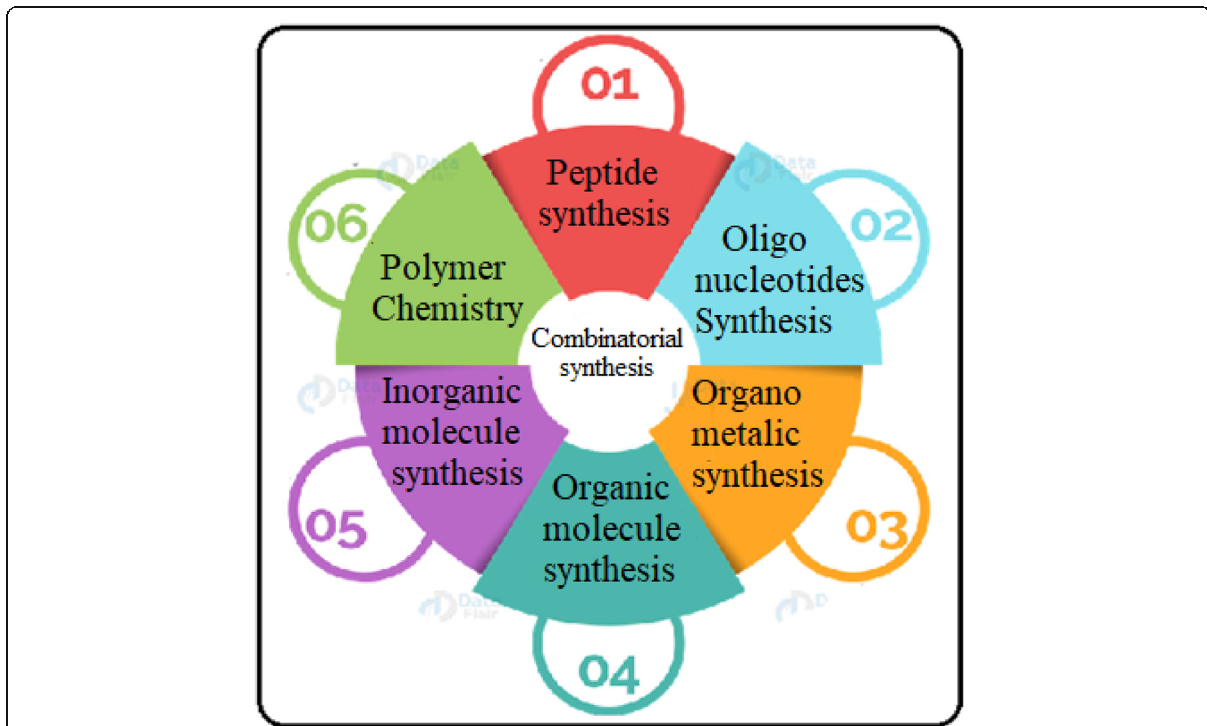
Fig. 2 Application of combinatorial